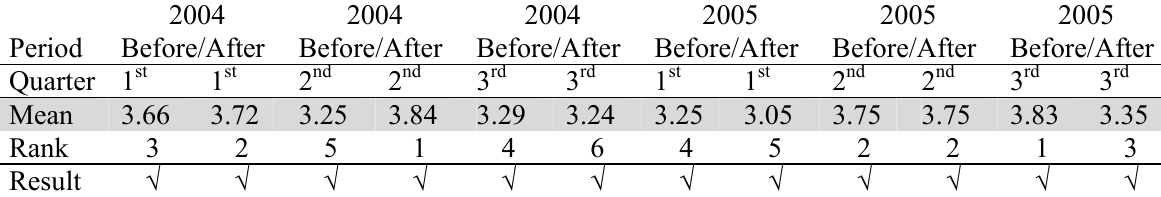
The results of testing the first hypothesis for the years of 2004-2005 2004 2004